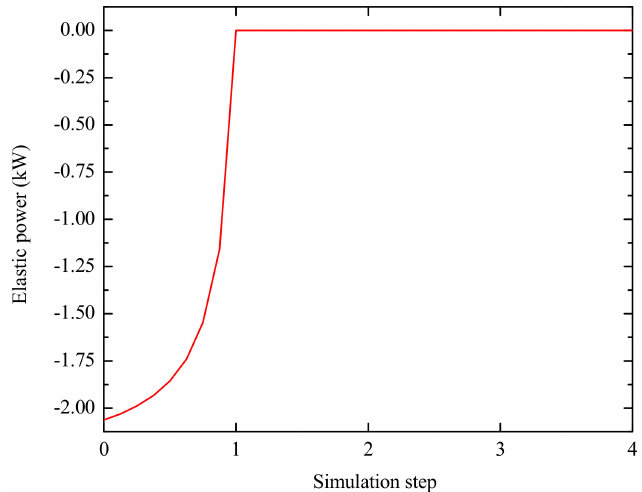
Figure 8. Elastic power during springback